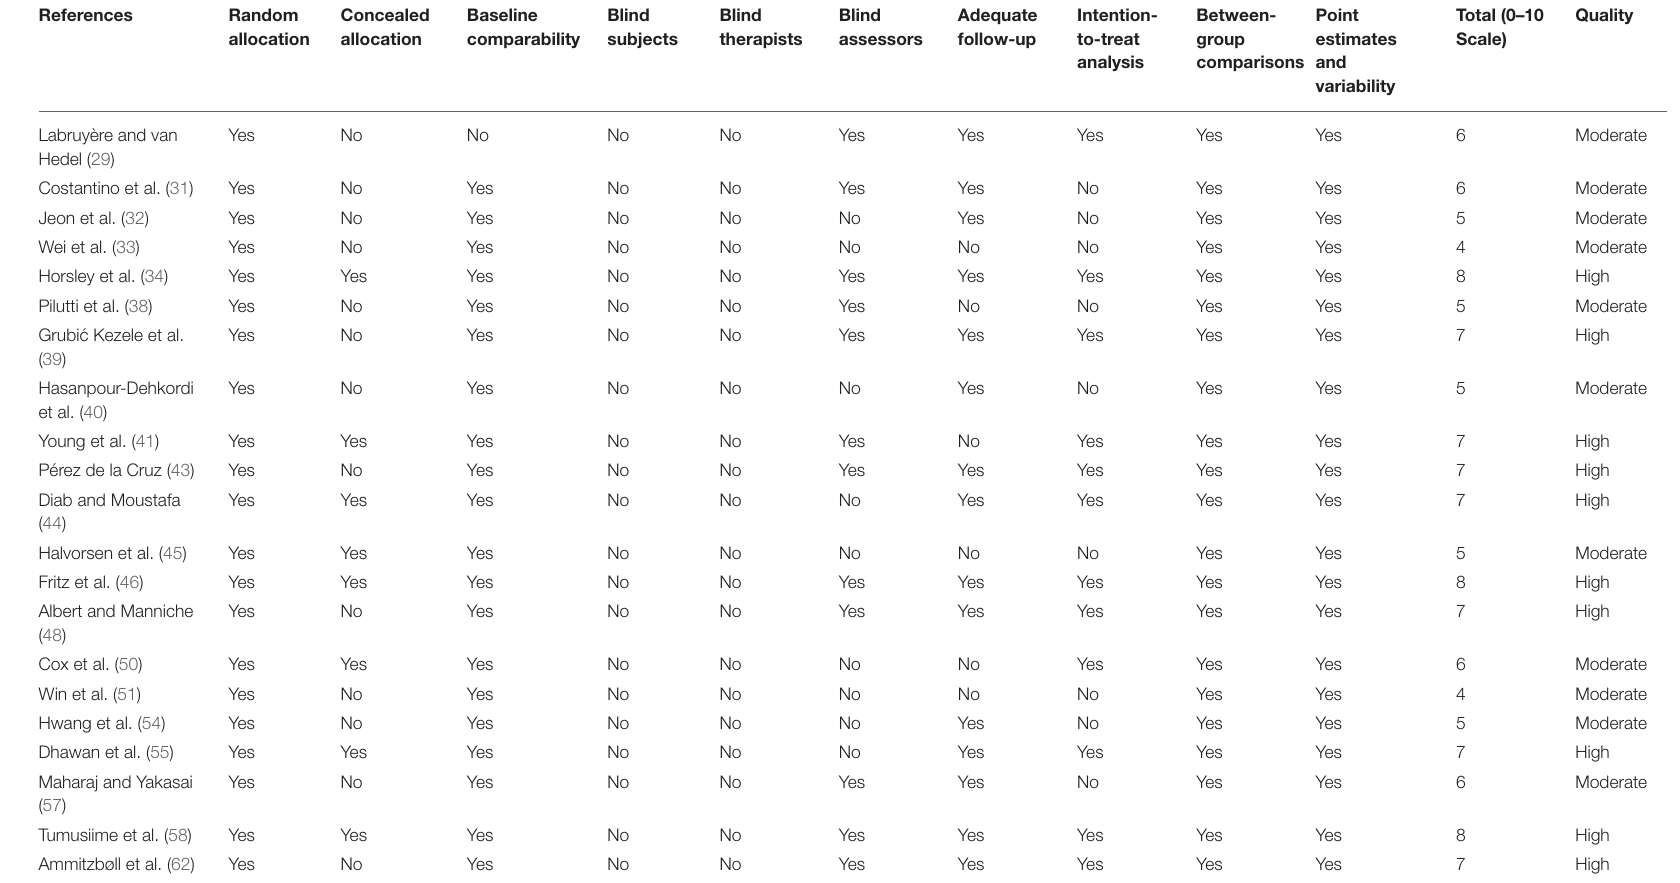
TABLE 5 | Physiotherapy evidence database scores of included RCT